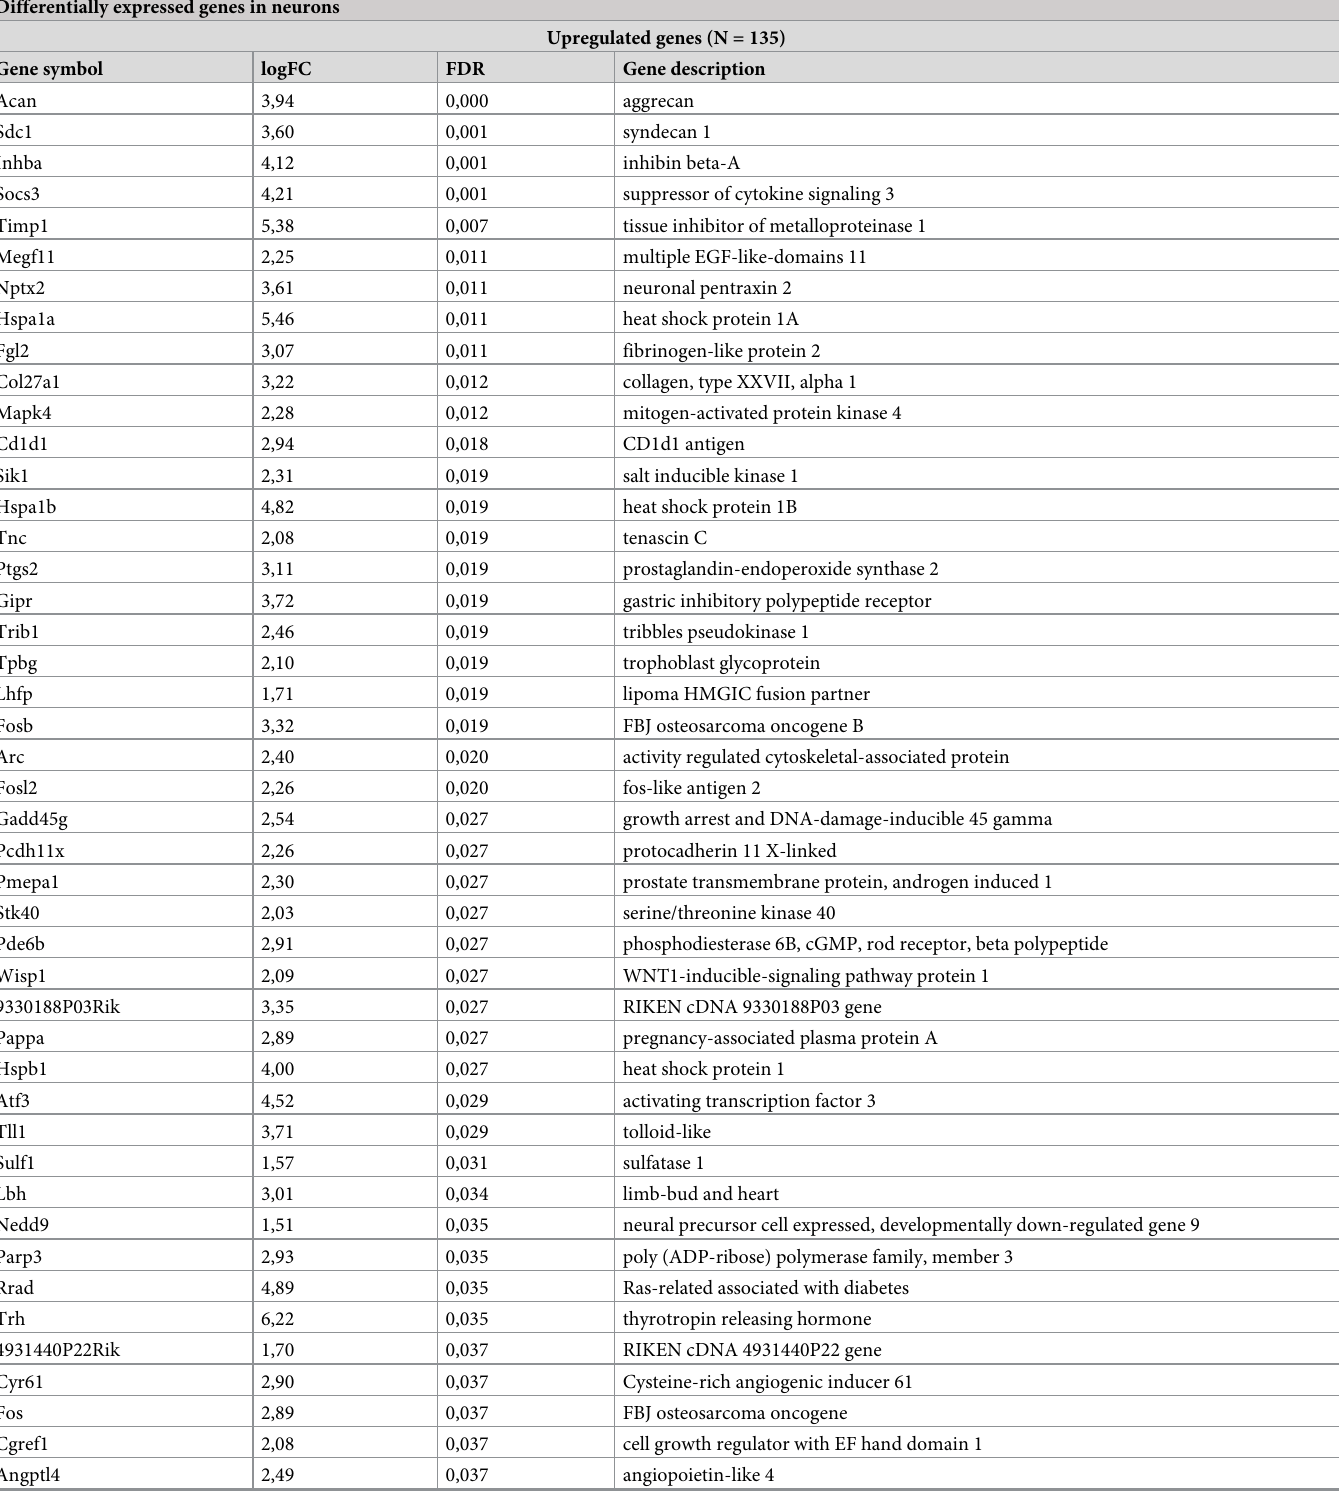
Table 1. Differentially expressed genes in neurons at 24 hours post injection in the intracortical kainic acid model of mTLE. Differentially expressed genes in